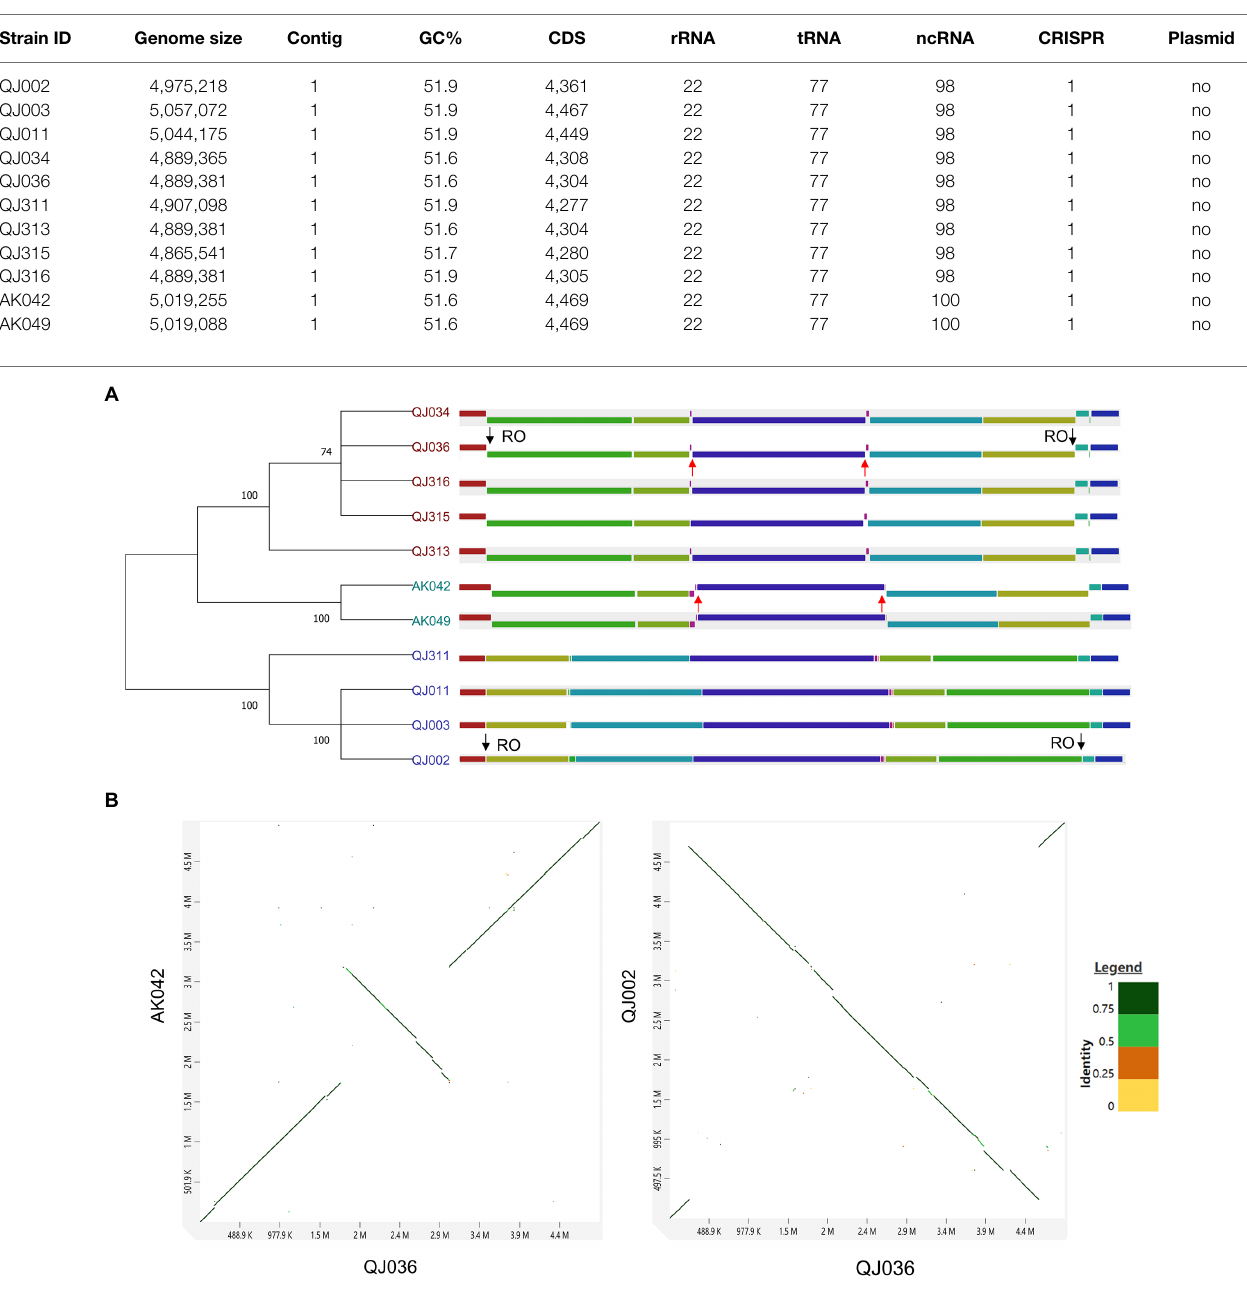
TABLE 1 | General genome characteristics of sequenced Pectobacterium aroidearum strains.